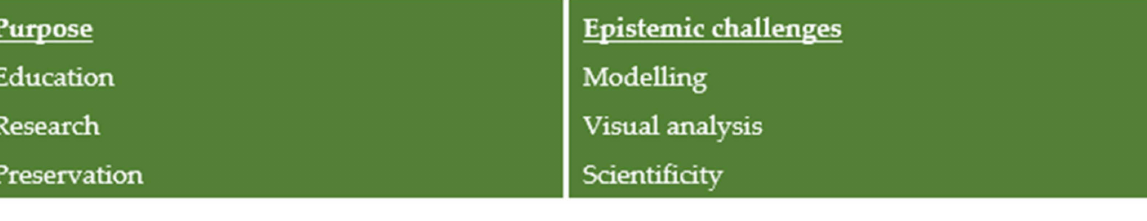
Figure 3. Chapter